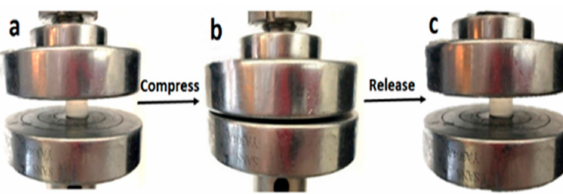
Figure 6. Photographs of the Agar / PAA / HEC DN hydrogel under compression.